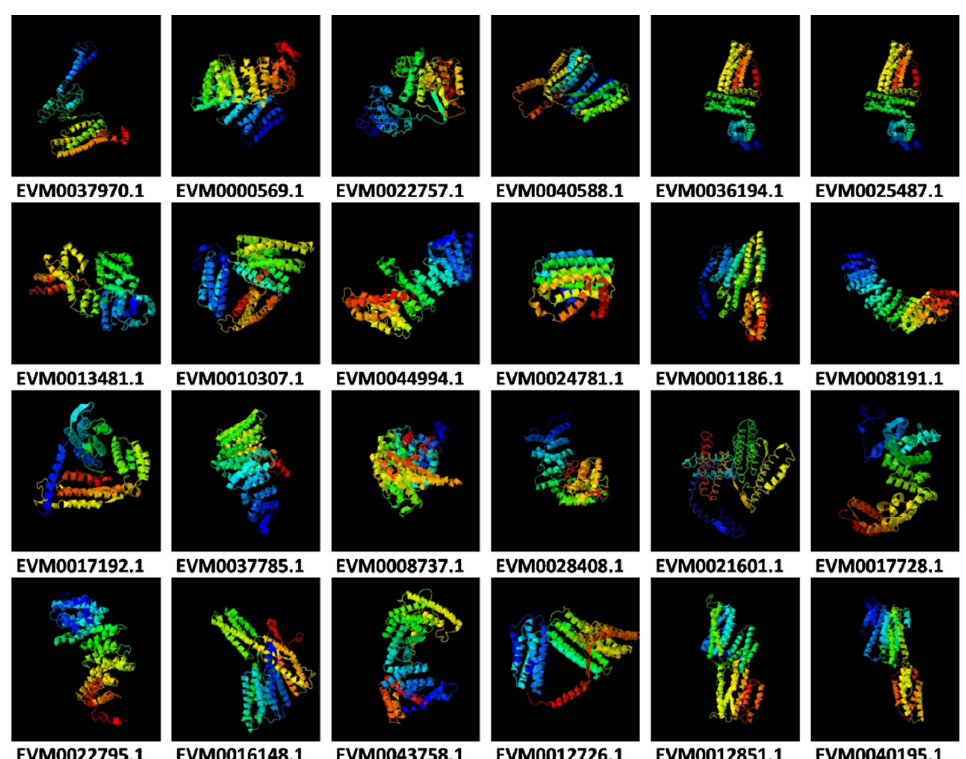
Figure 1. The predicted structures (3D) of ALMT proteins in loquat. The protein chains are colored as blue at the N-terminus and red at the C-terminus. The secondary structures in the model are highlighted in green (for α -helices) and yellow (for β -strands). Horticulturae 2021 , 7 , x FOR PEER REVIEW